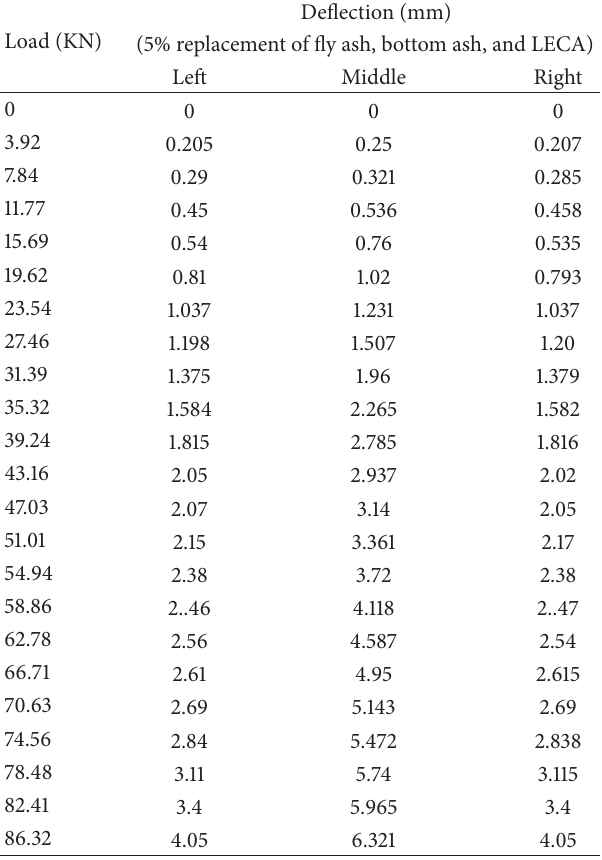
Table 5: Load versus deflection of beam with optimum mix. Load (KN)